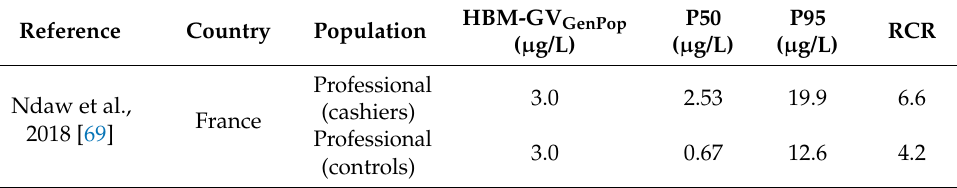
Table 5. Summary of HBM data and calculated RCRs for total BPS for the occupational